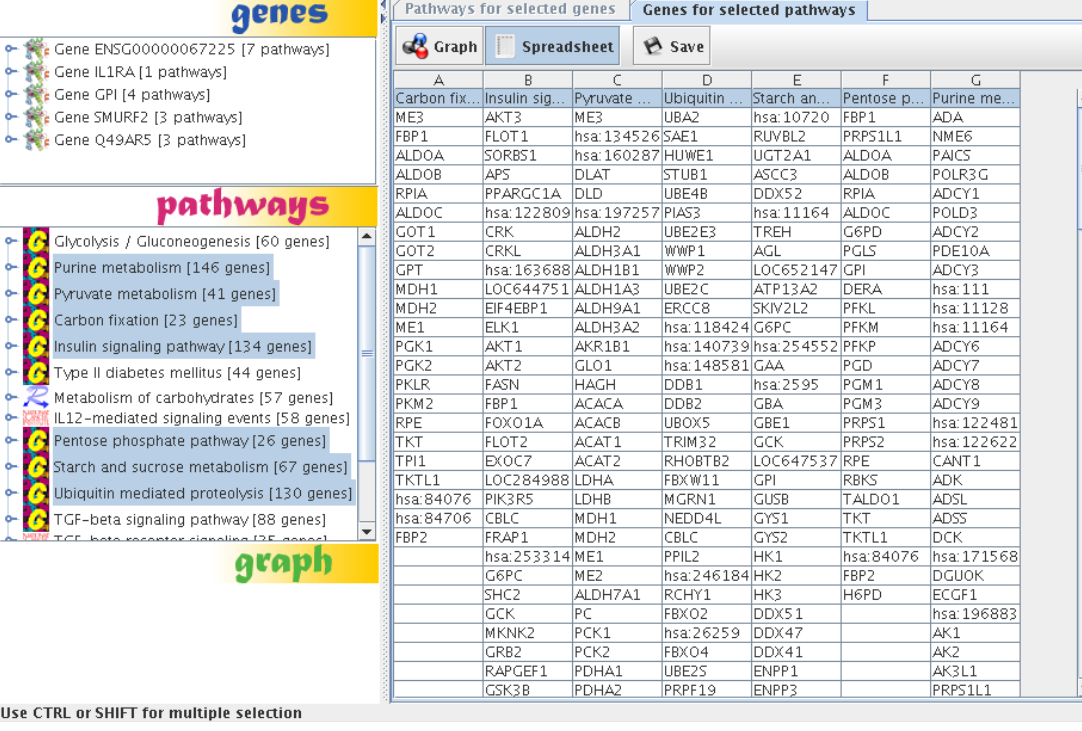
Figure 4: Exportable raw-data view of PathJam results. The spreadsheet layout of PathJam allows users to easily copy/paste obtained results to other